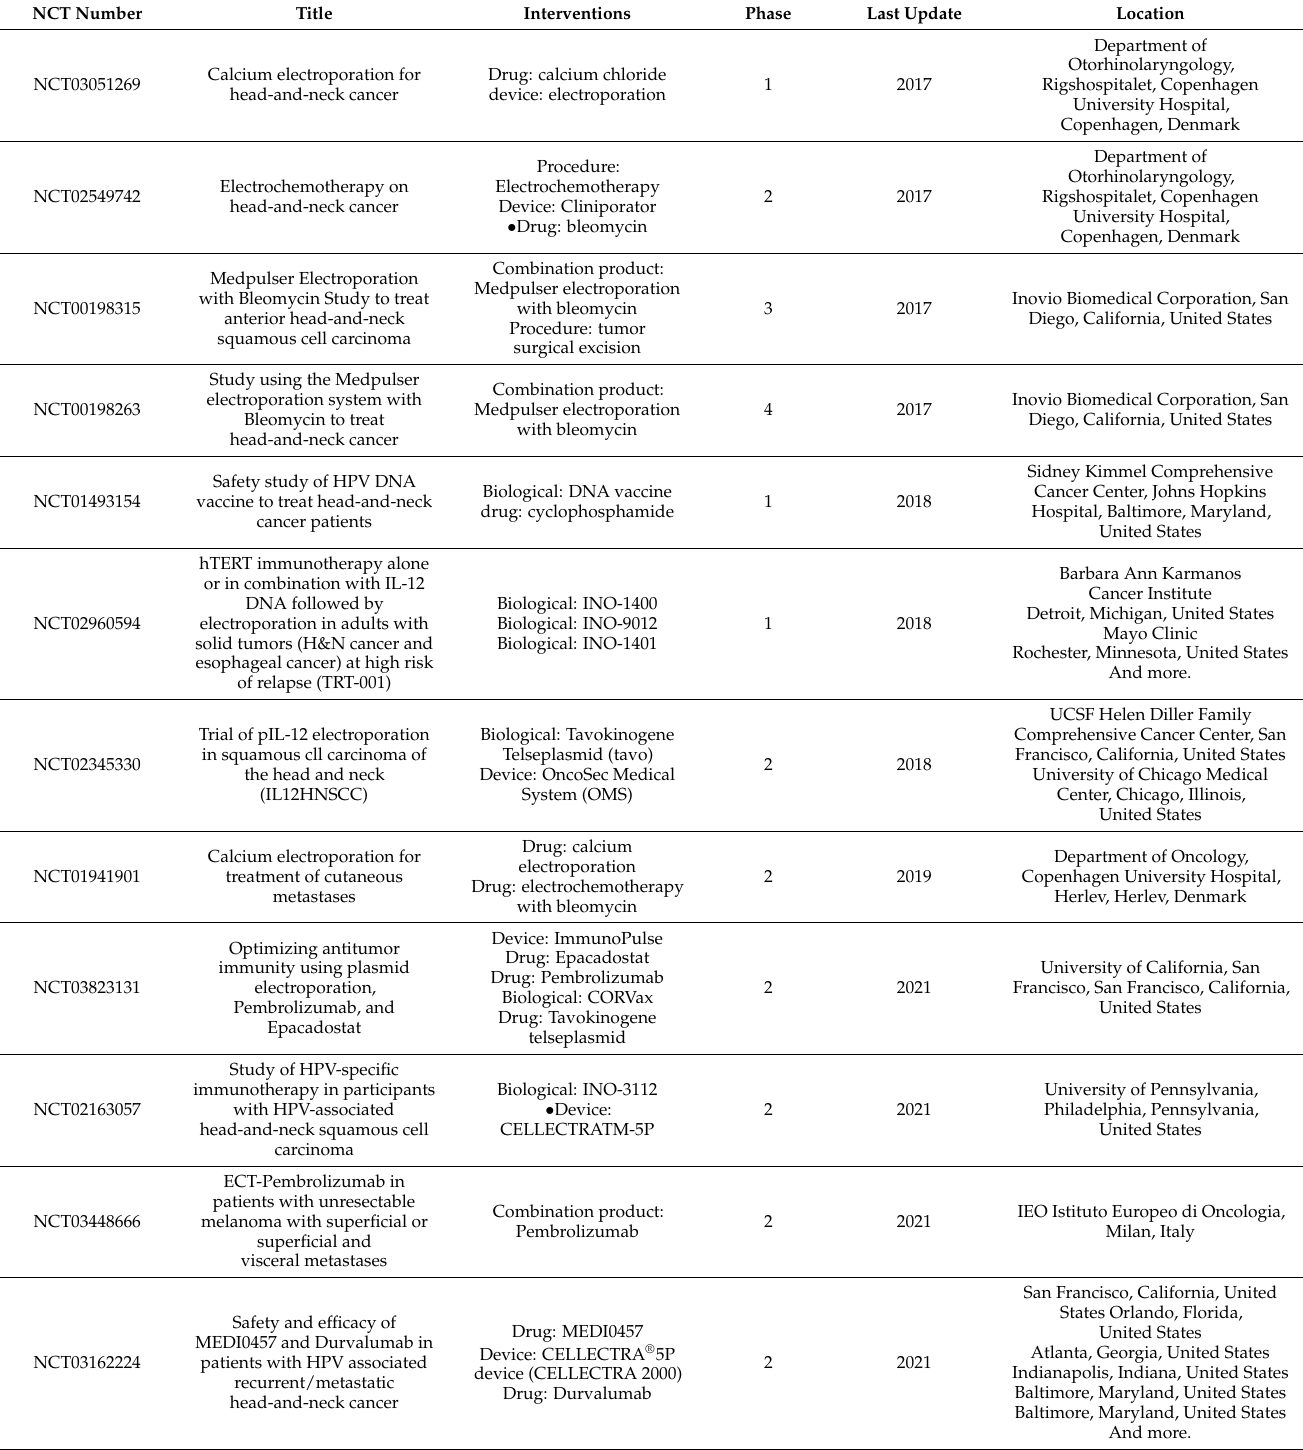
Table 3. Clinical trials (www.clinicaltrials.gov) that involved electroporation in the H&N cancer